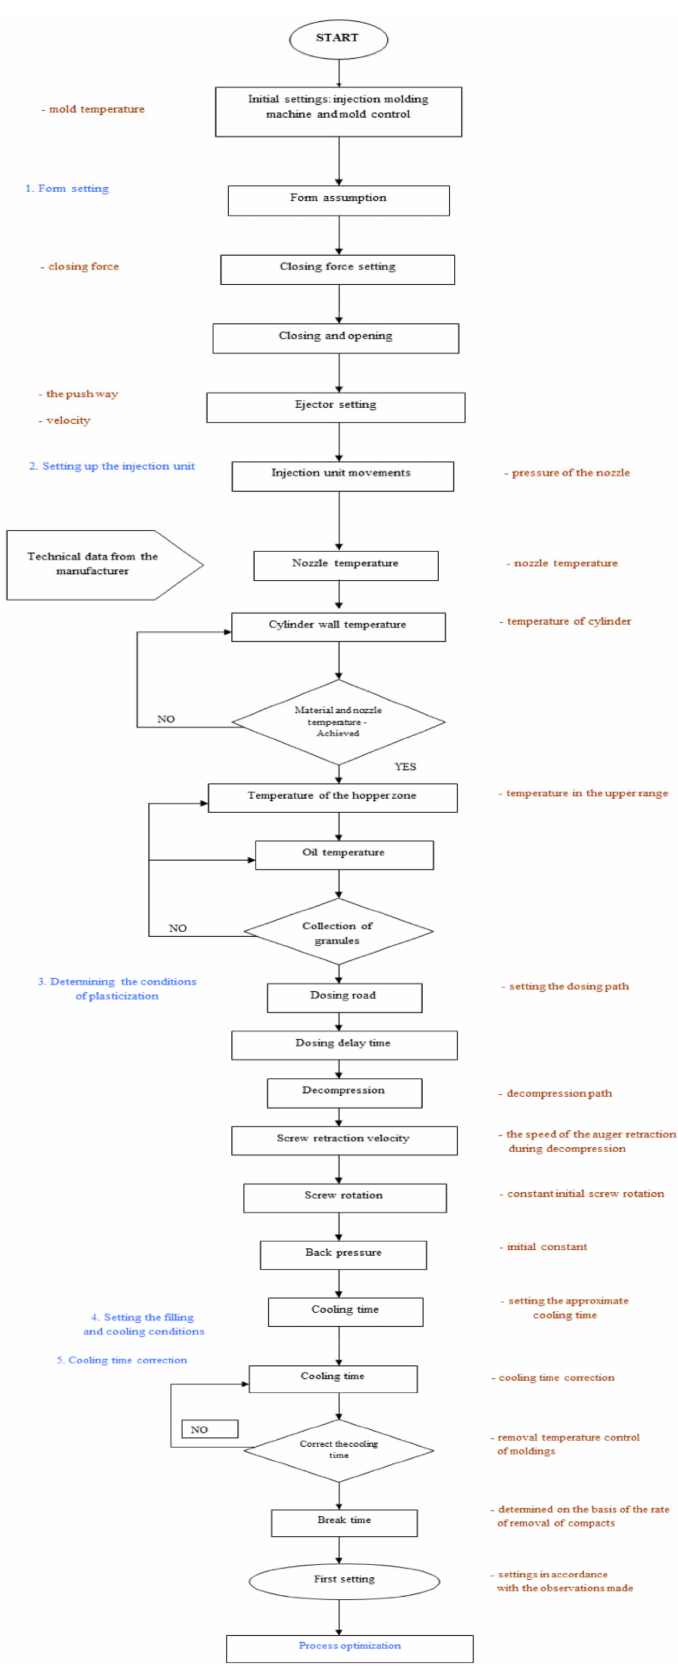
Figure 6. Block diagram of the injection process parameters